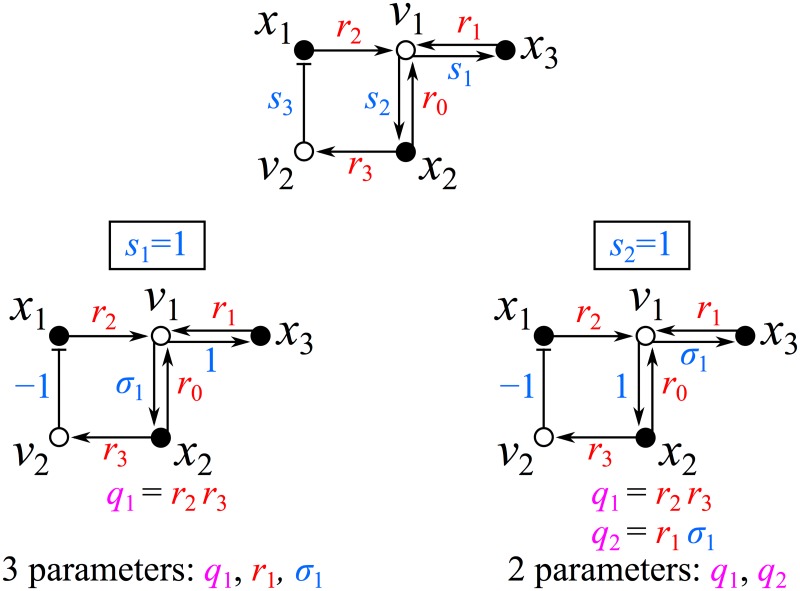
Non-redundancy of stoichiometric reduction and cycle compaction.The displayed network (top) provides a concrete example of the non-redundancy of stoichiometric reduction and cycle compaction. At the top, all Jacobian parameters (r
0 = 1, r
1, r
2, r
3) and stoichiometric parameters (s
1, s
2, s
3) of the network are labeled. Stoichiometric reduction of reaction v
1 allows the setting of either s
1 (bottom left) or s
2 (bottom right) to unity. The choice of s
1 = 1 followed by cycle compaction leads to three final parameters (3D stability phase space), whereas the better choice of s
2 = 1 leads to only two final parameters (2D stability phase space).